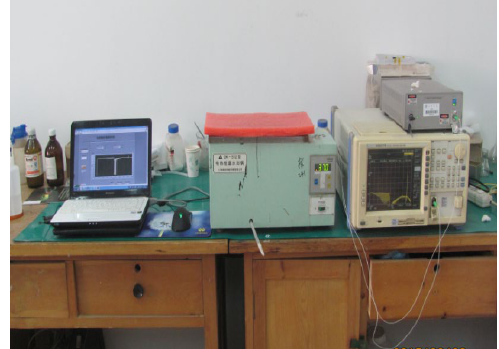
Fig. 3 Site of hybridization